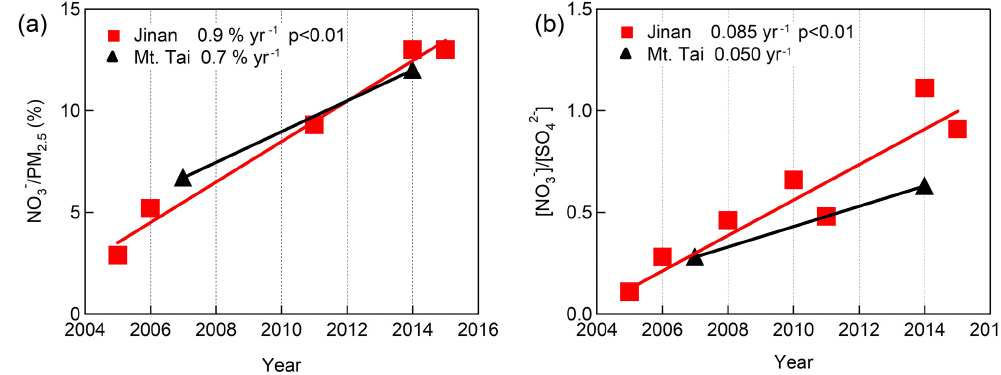
/ SO 2 − /PM 2 . 5 and (b) molar ratio of NO − in urban Jinan and at Mt. Tai in summertime 3 3 4